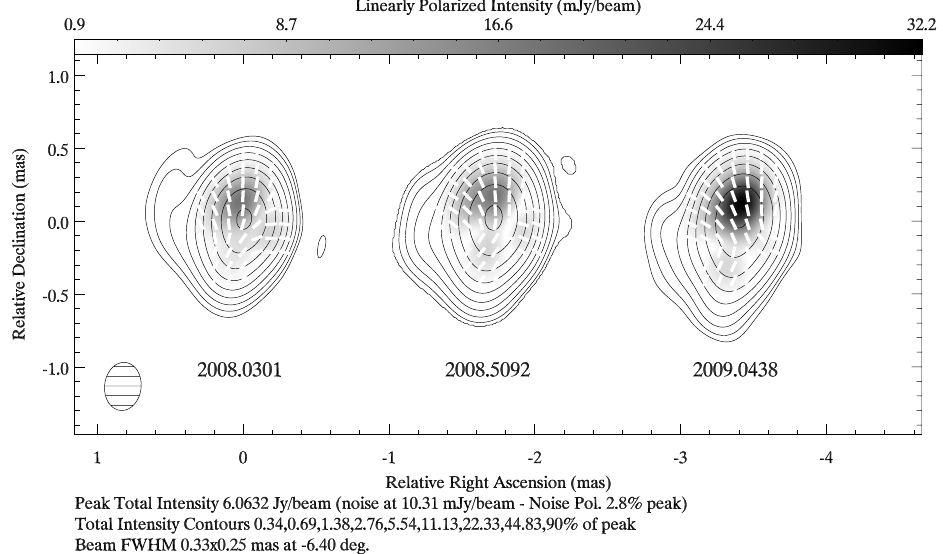
Figure 1. Sequence of three VLBA images at 22 GHz from 2008 to 2009. Contours show the 22 GHz total intensity. Grey scale represents the linearly polarized intensity, and the short white sticks indicate the electric vector position angle distribution. A common convolving beam, as shown in the lower-left corner of the plot, was used for all images. Note that the length of the white sticks is homogeneous over the images, i.e., not proportional to the polarization